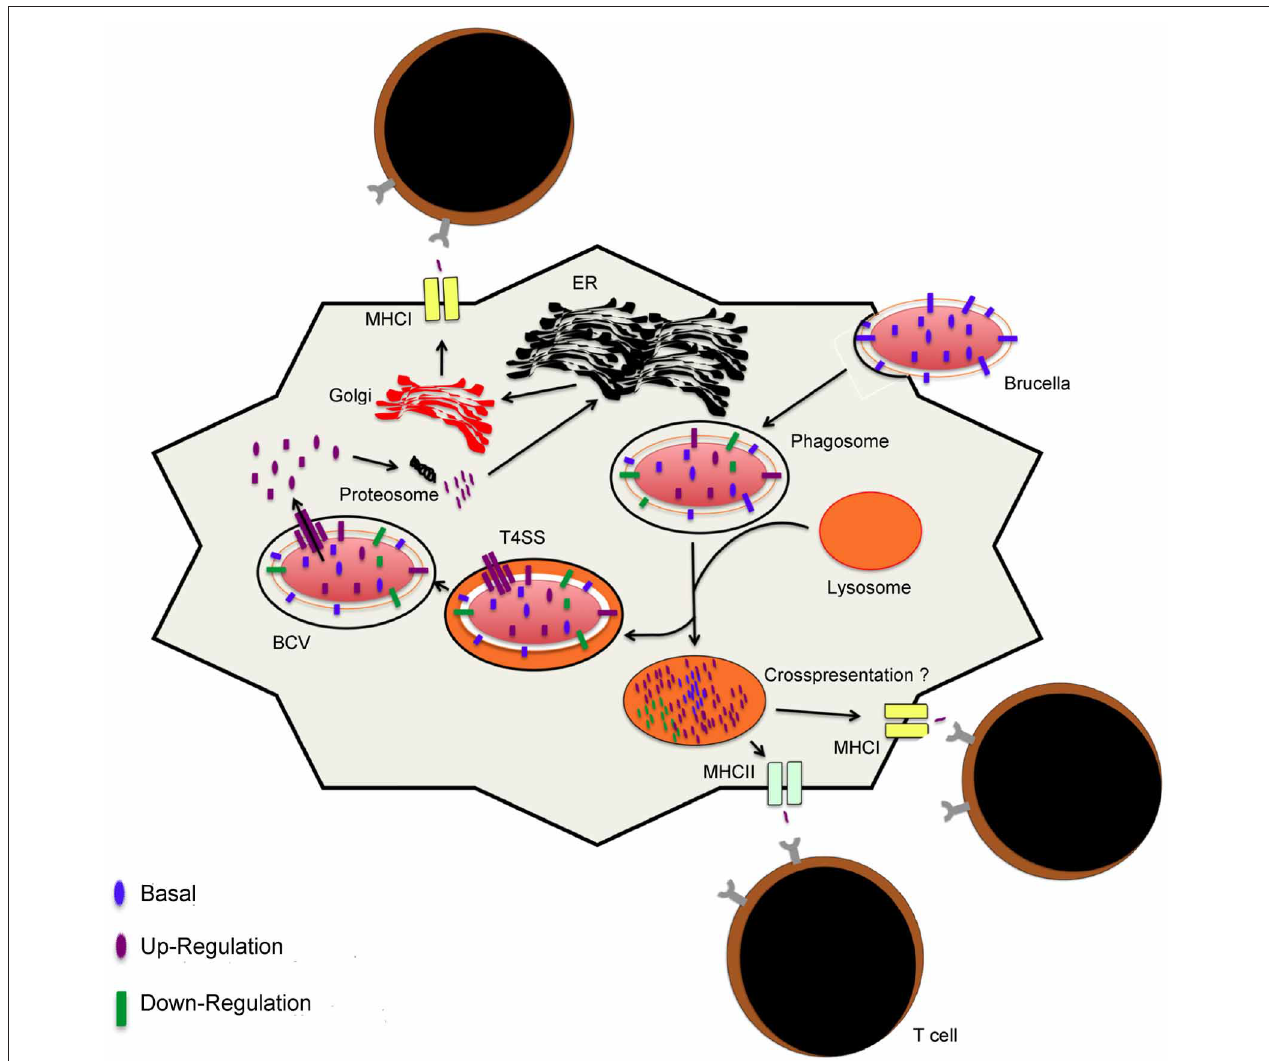
FIGURE 3 | Model for antigen presentation during Brucella infection. Upon internalization of Brucella , the conditions in the vacuole trigger changes in the gene expression profiles. Interactions or fusion with the lysosomes result in changes that support intracellular replication or lead to Brucella degradation, respectively. Peptides that result from degradation are presented via MHCII to helper T cells or, presumptively, to cytotoxic T cells